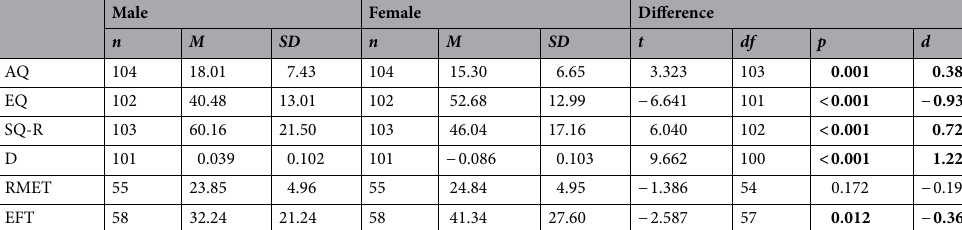
Table 1. Descriptive statistics and sex differences for autism-related variables. AQ, Autism Spectrum Quotient; EQ, Empathy Quotient; SQ-R, Systemizing Quotient-Revised; D, difference in standardized EQ (E) and SQ-R (S) scores; RMET, Reading the Mind in the Eyes Test; EFT, Embedded Figures Task. Effects in bold are statistically significant ( p < 0.05, two-tailed).